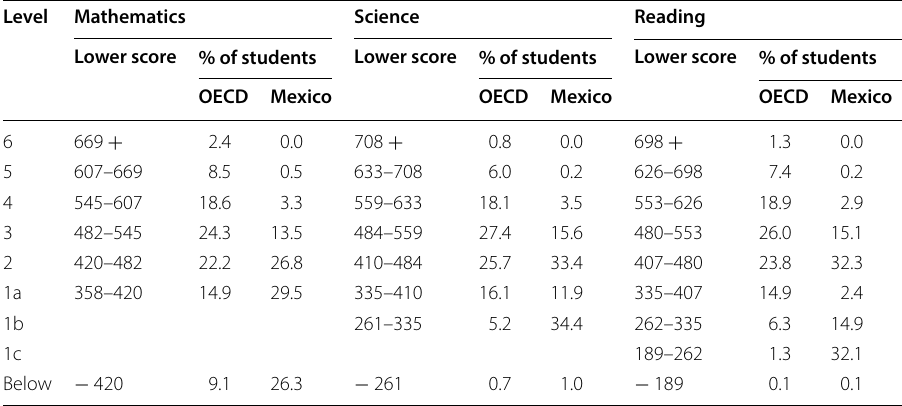
Table 3 Percentage of students by PISA Proficiency levels by area of knowledge, OECD and Mexico, 2018 Source: PISA 2018, OECD and own estimations with data from PISA 2018